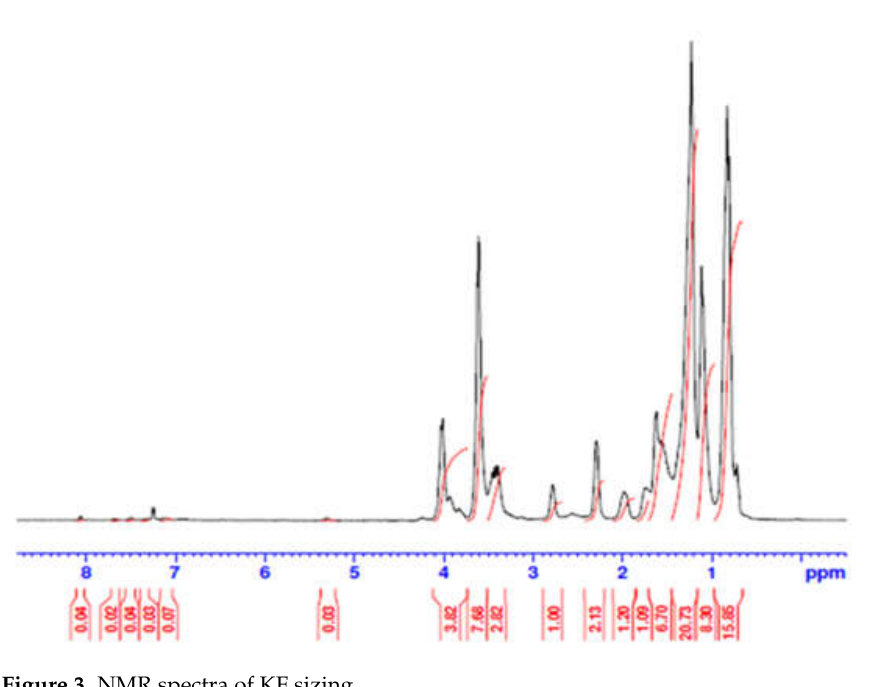
Figure 3. NMR spectra of KF sizing.